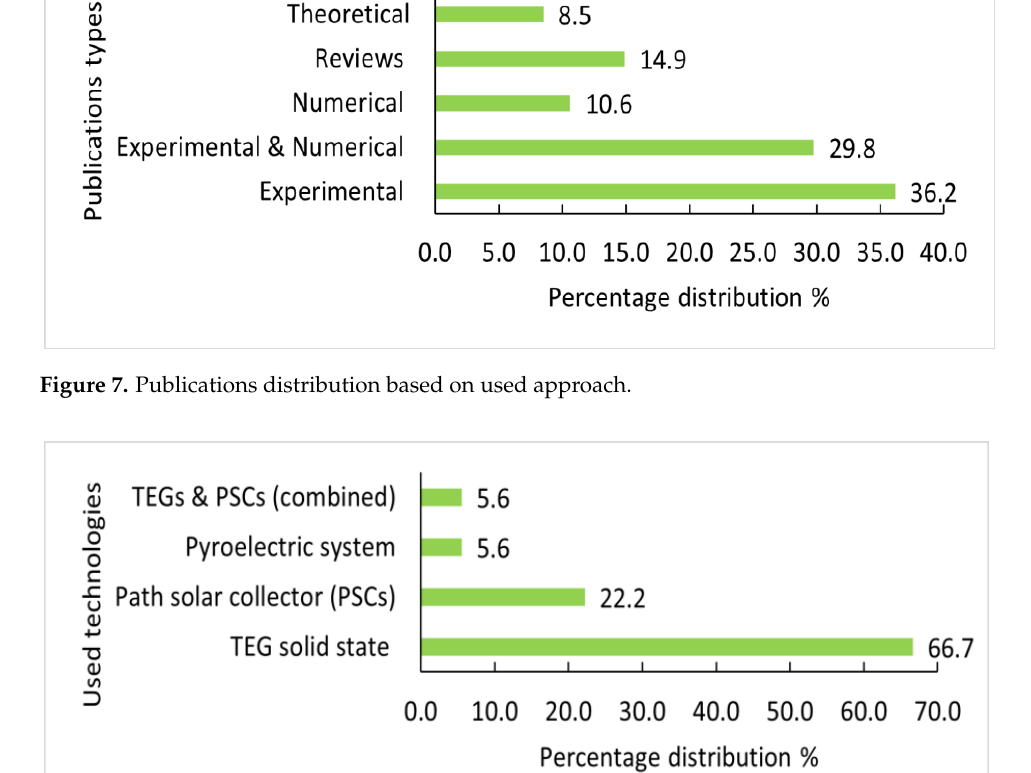
Figure 9. Co-occurrence mapping of author keywords.